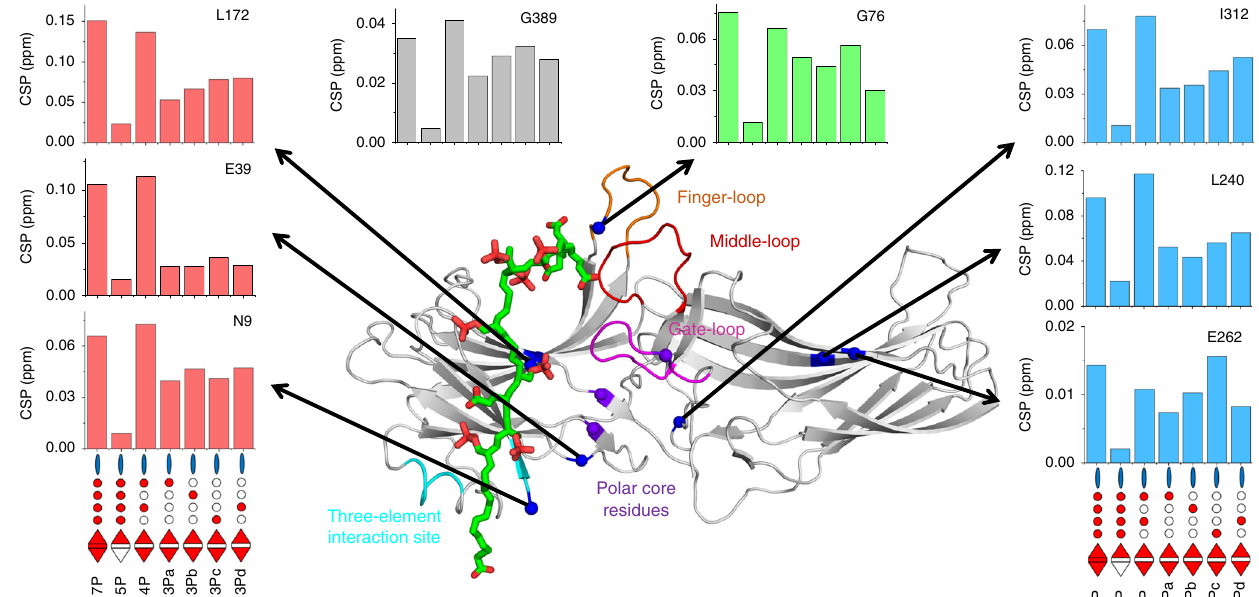
Fig. 7 Phosphorylation patterns modulate the conformation of arrestin-1. The magnitude of chemical shift perturbations of individual residues caused by different phosphopeptides is illustrated by barplots. The locations of these residues (blue spheres) are indicated on a model of active arrestin-1 in complex with the fully phosphorylated rhodopsin C-terminal peptide (own work; negatively charged and phosphorylated residues are highlighted in red, C-terminus of peptide is at bottom). Note the location of G389 is not shown because the C-tail was not included in the model. The barplots are colored according to residue location in different functional regions of arrestin-1: on or near the polar core (red), C-tail (gray), central crest (green) and C-domain (blue). Additionally, four regions important for arrestin activation are highlighted: the fi nger loop (orange, G68-L77), the middle-loop (red, Q133-S142), the gate loop (magenta, D296-N305), the three-element interaction (cyan, H10-I13, L107-L111) and the polar core (purple spheres, R175, D30,